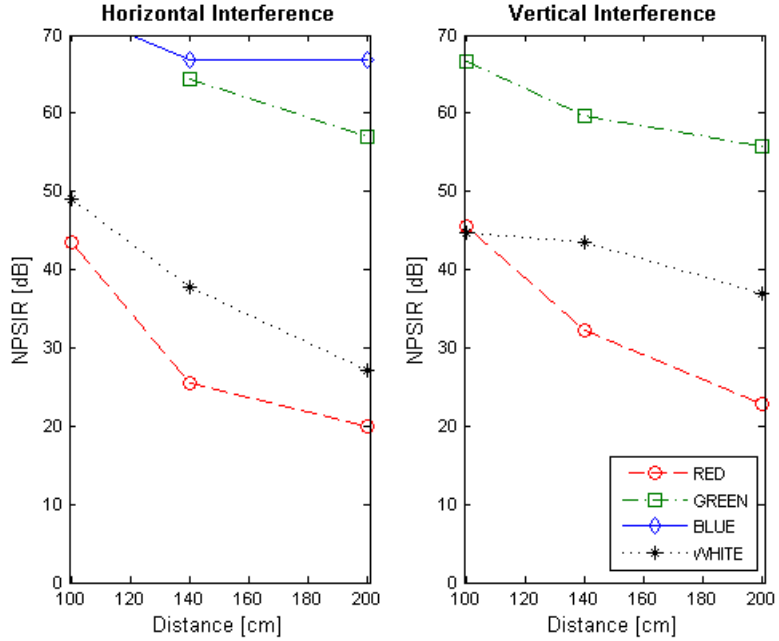
Figure 15. Normalized Power Signal to Interference Ratio for transmitting in red. The left chart presents the interference of close emitters located on the same horizontal line. Right chart shows the interference of the transmitters within the same vertical